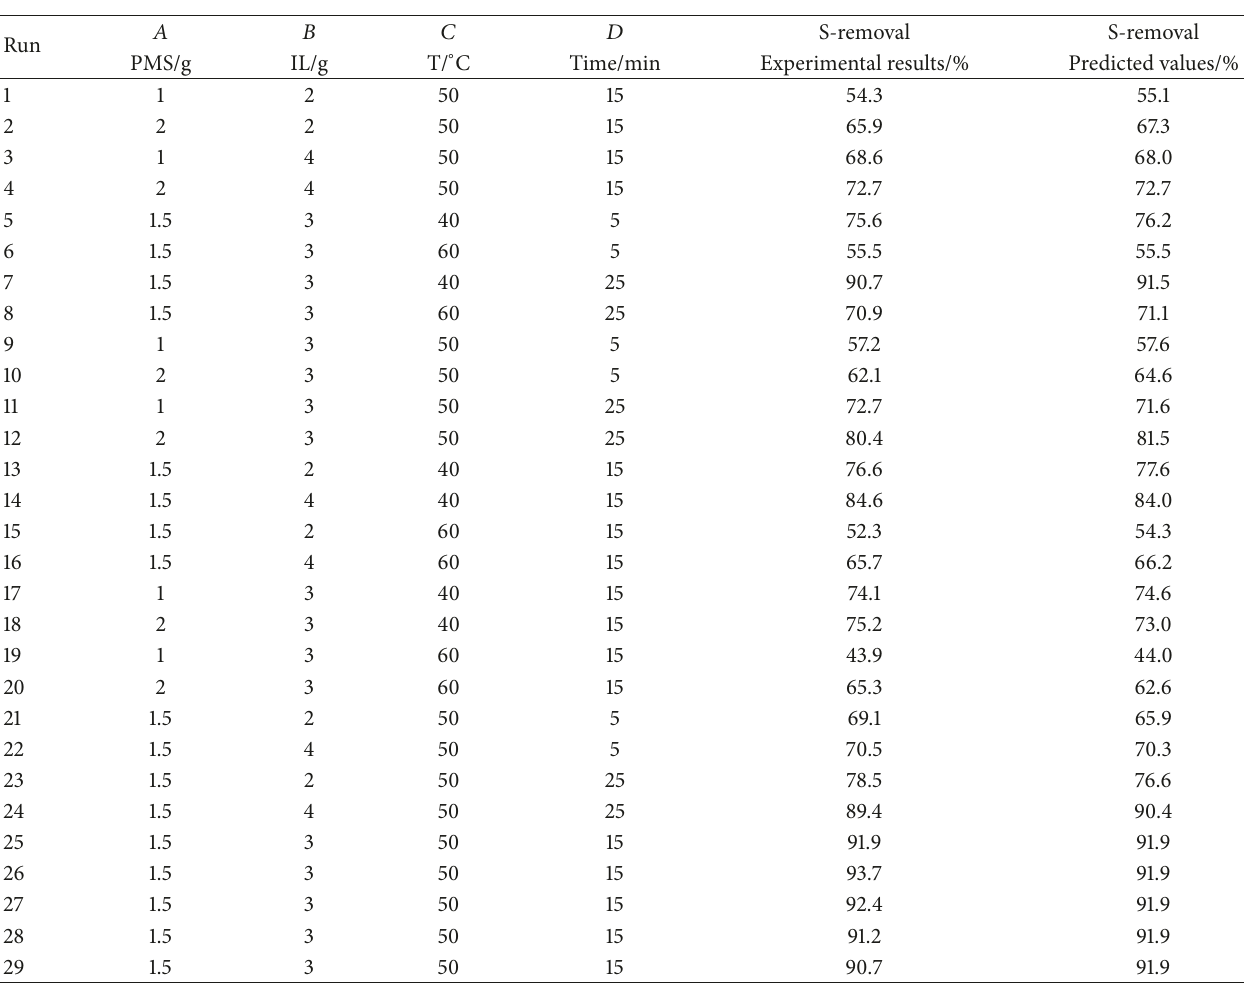
Table 2: Experimental design matrix and results for process optimization.